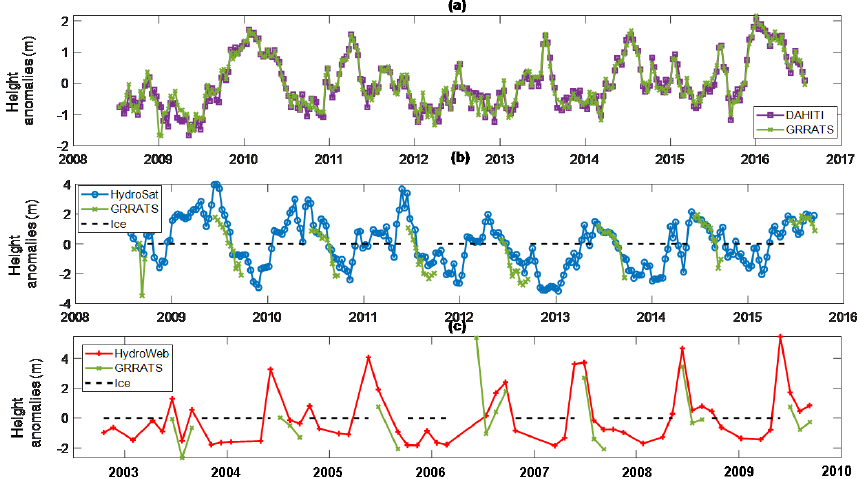
Figure 5. Multiproduct evaluation at ungaged river locations. GRRATS is plotted in green, DAHITI in purple with square markers, HydroSat in blue with circle markers, Hydroweb in red with cross markers, and times of ice cover with a dotted black line. Panel (a) is a comparison with DAHITI on the Paraná River. Panel (b) is a comparison with HydroSat on the Ob River. Panel (c) is a comparison with Hydroweb on the Lena river.